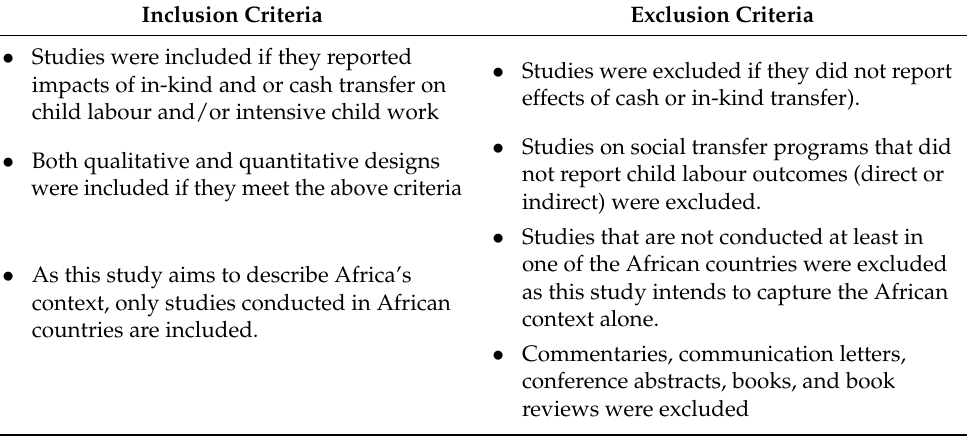
Table 1. Study Selection